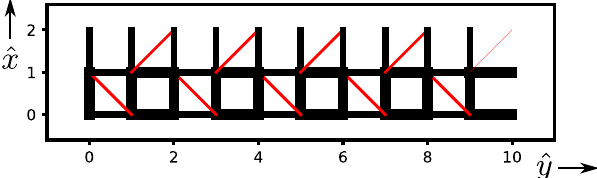
i within the · S i j